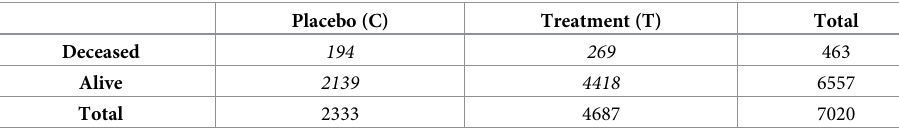
Table 2. Mortality figures in the Empa-REG-Outcome Trial